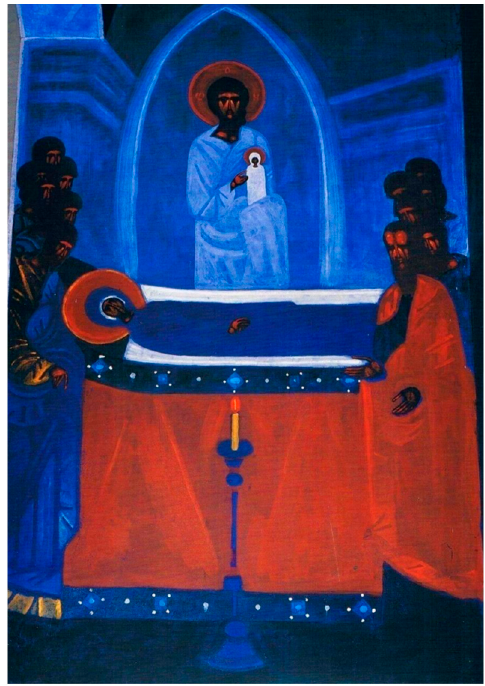
Figure 5. Jerzy Nowosielski, Dormition of the Blessed Virgin Mary. Polychrome of the Greek Catholic church in Lourdes, France, 1984. Photography by the author.